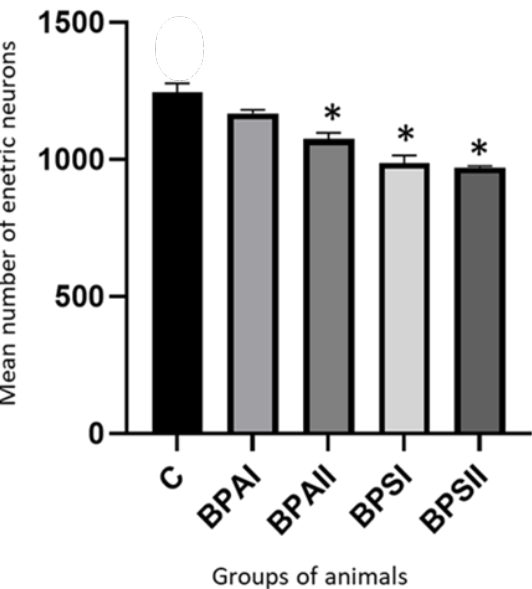
Figure 5. Mean number of enteric neurons ( ± SEM) counted in 50 MP ganglia in control animals (C), after administration of BPA in low (BPA I) and high dose (BPAII) and after administration of BPS in low (BPSI) and high (BPSII) dose. Statistically significant differences between particular groups of animals and control group are marked with *.